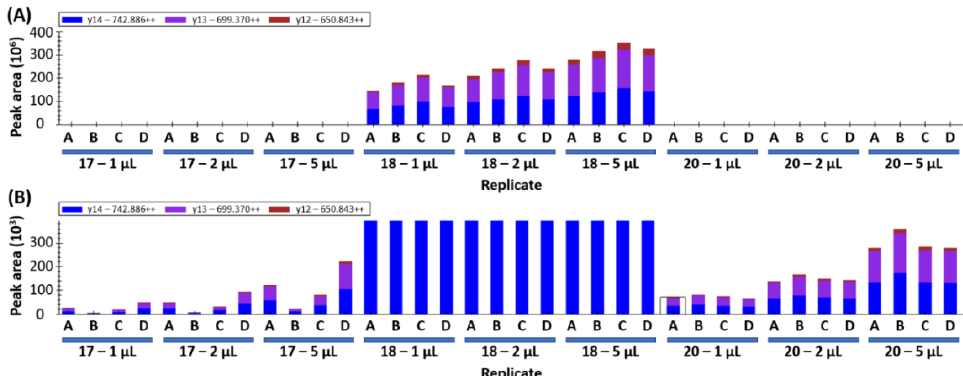
Figure 2. Wheat peptide (DVSPGCRPITVSPGTR from HMW-GS, Uniprot: Q45R38) peak area measurement using increasing injection volumes (1, 2, and 5 µ L) of samples 17, 18, and 20. The four technical replicates are indicated by the letters A–D, the colored columns indicate the peak area for the three MRM transitions. ( A ) shows the full range of peak area, whilst ( B ) shows a zoomed in y -axis allowing the view of the trace level gluten detection in samples 17 and 20.